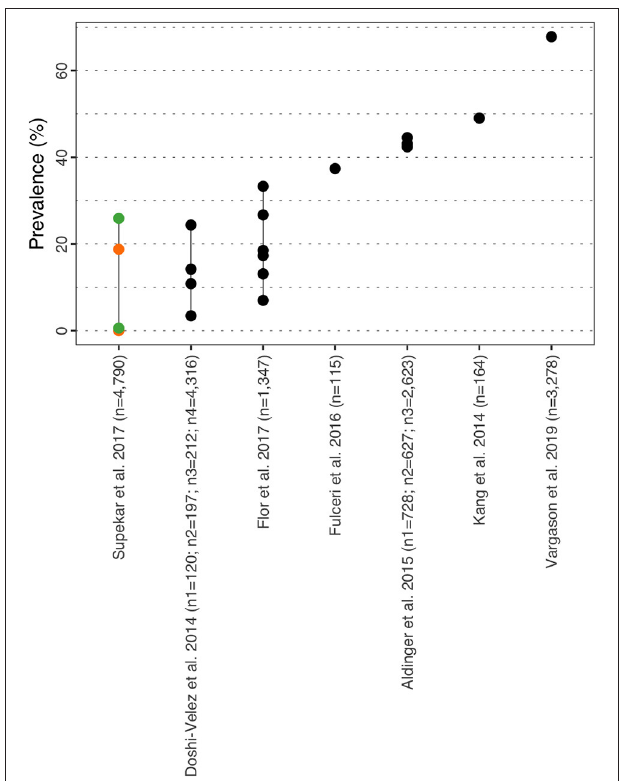
FIGURE 7 | GI prevalence estimates. Each point reports a prevalence estimate for the related comorbidity. Studies with more than one data point indicate the estimate of the prevalence among different subgroup of the population. See Supplementary Table 4 for the description of the population used in each study. Sample sizes are shown in brackets above each study label. Orange mark: Female population only; Green mark: Male population only; Black mark: No sex distinction.